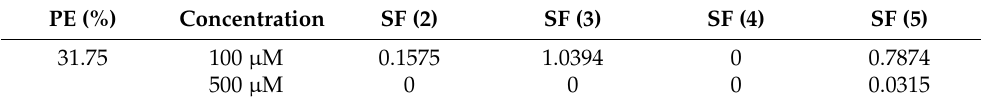
Table 2. Plating efficiency (PE) and surviving fraction (SF) for peptides 2 – 5 .